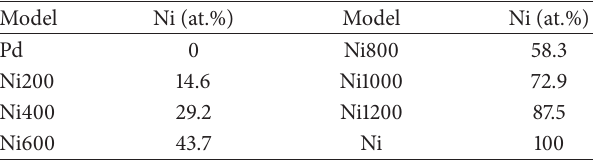
Table 1: Content of nickel of every cluster model. Model Ni (at.%) Model Ni (at.%) Pd 0 Ni800 58.3 Ni200 14.6 Ni1000 72.9 Ni400 29.2 Ni1200 87.5 Ni600 43.7 Ni